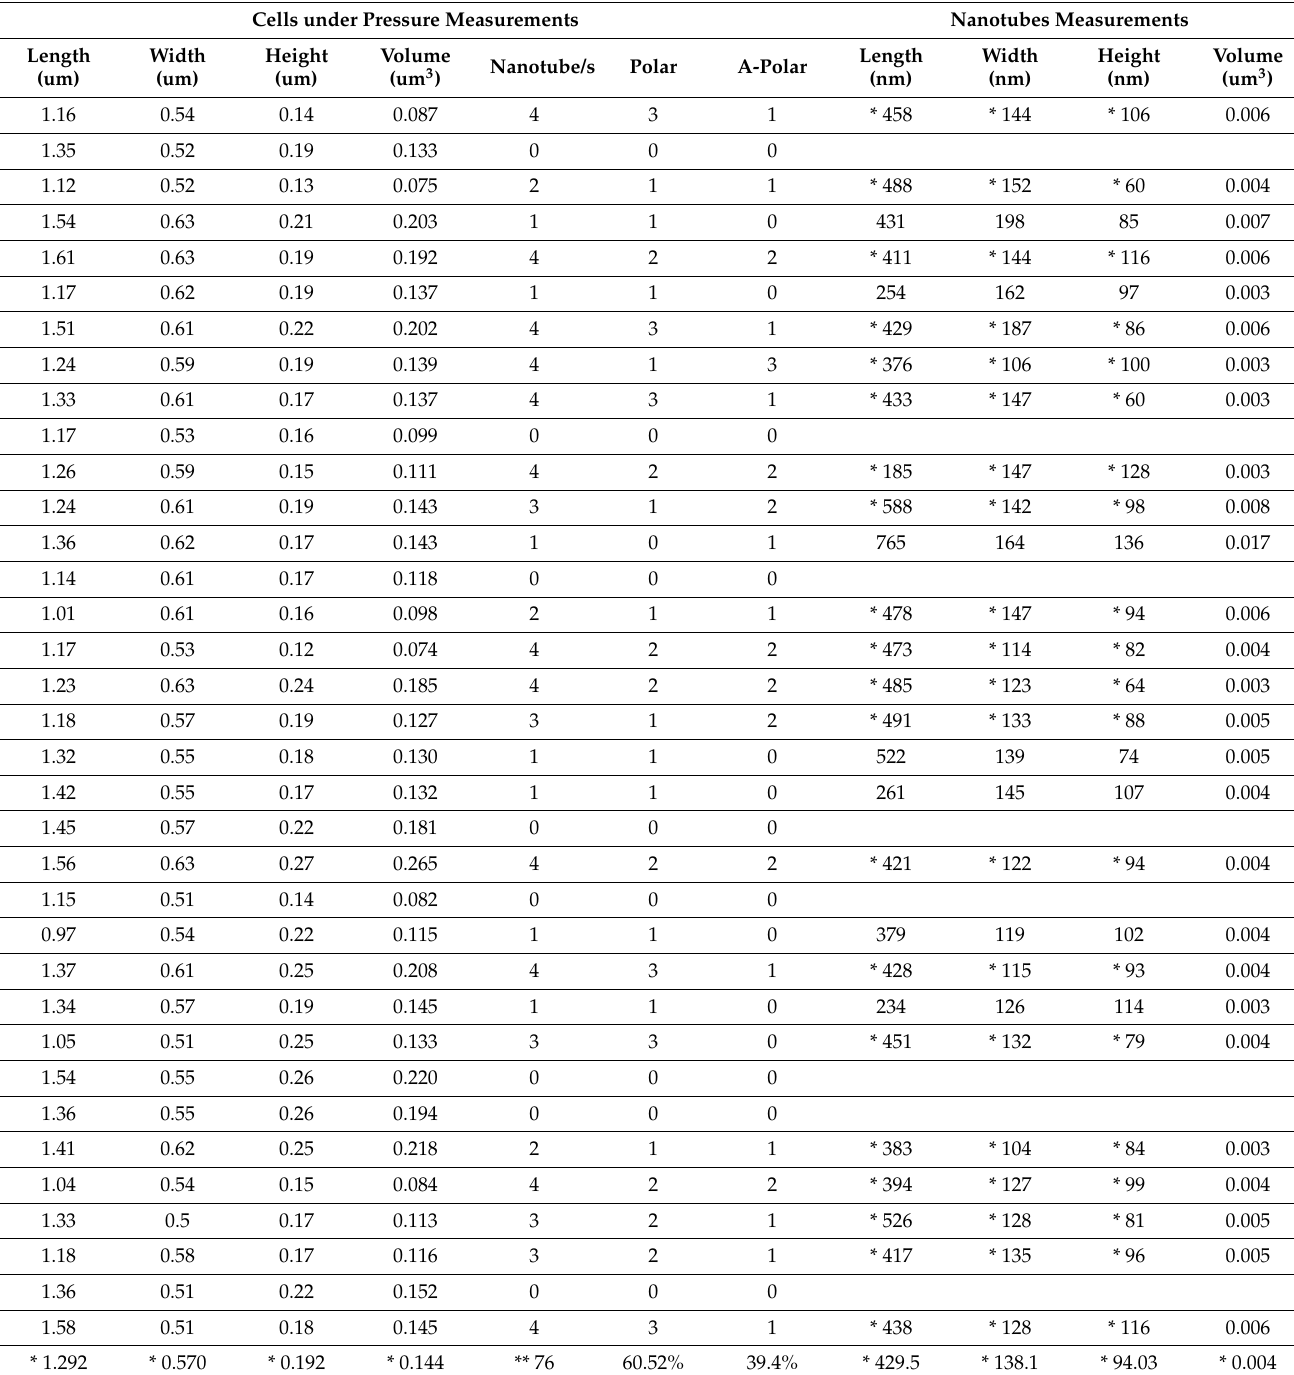
Table 2. Physical Measurements (Total volume including cell length, width and height) of 35 randomly selected cells from a biofilm population of 350 cells. These cells were recovered from biofilm consortia developed in between two slides under a weight of (15.45 g). All estimates were analyzed using Gwyddion